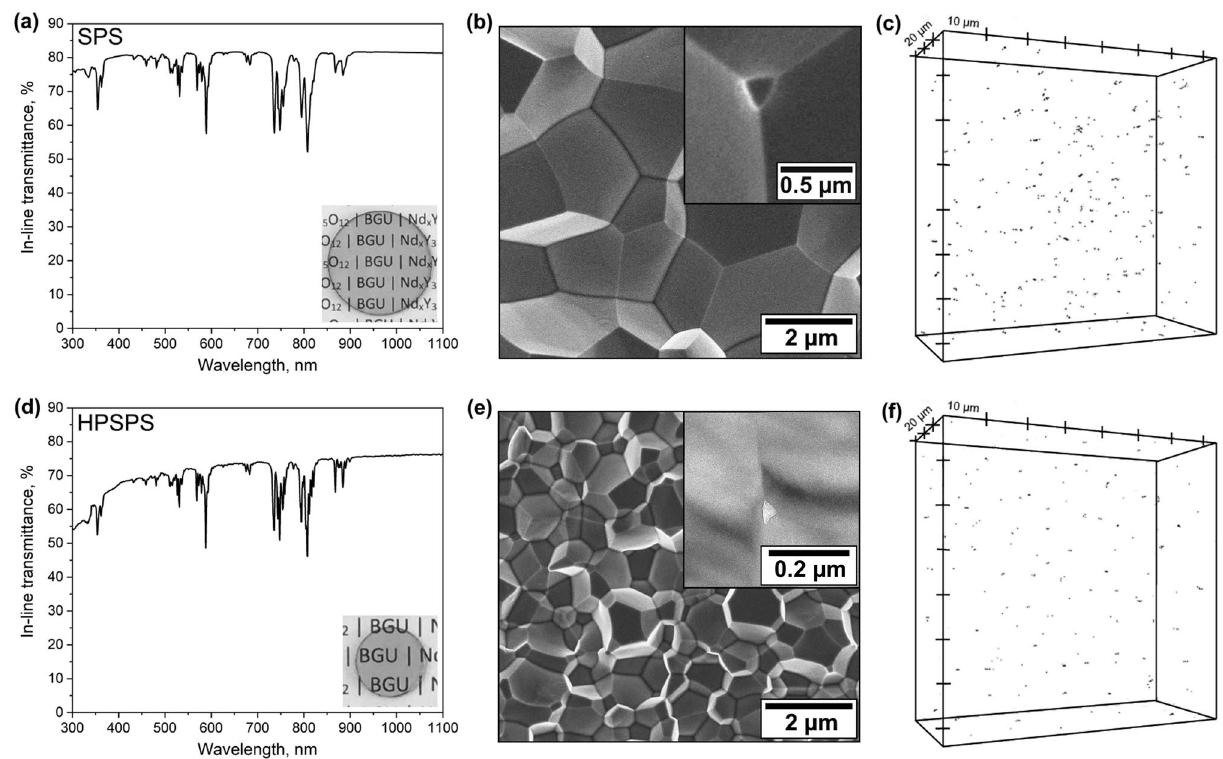
Figure 2. SPS-processed 1.5 at% Nd:YAG ( a ) in-line transmittance spectrum, sample appearance insert, ( b ) SEM image of fracture surface microstructure, close-up on pore in top insert and ( c ) porosity distribution obtained by CLSM in reflection mode. The same follows for the HPSPS-processed 1.5 at% Nd:YAG sample ( d – f ) with insert in ( e ) being a TEM image.